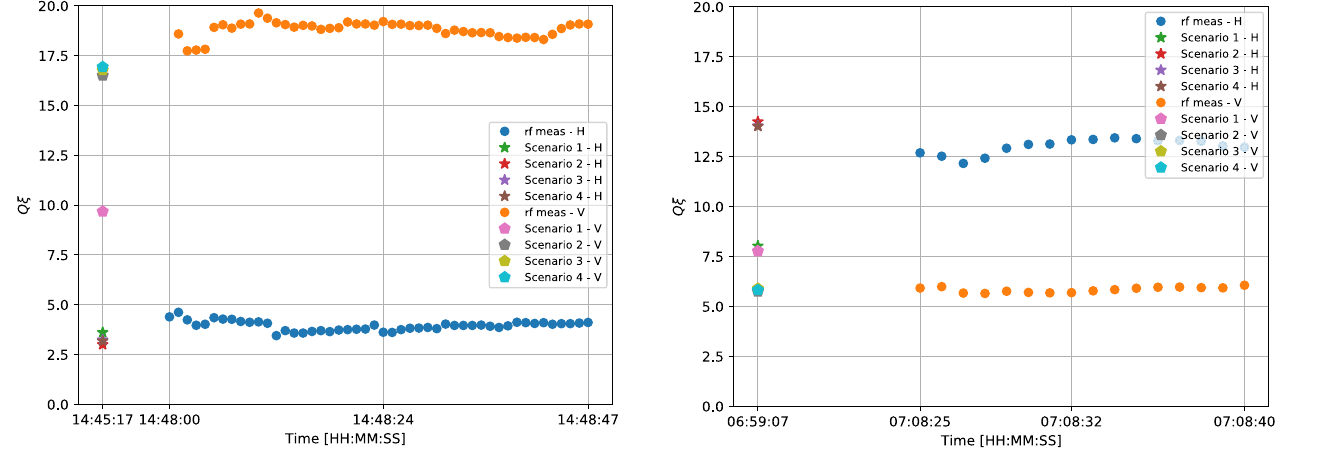
FIG. 9. Chromaticity measurements during LHC fill 7486.